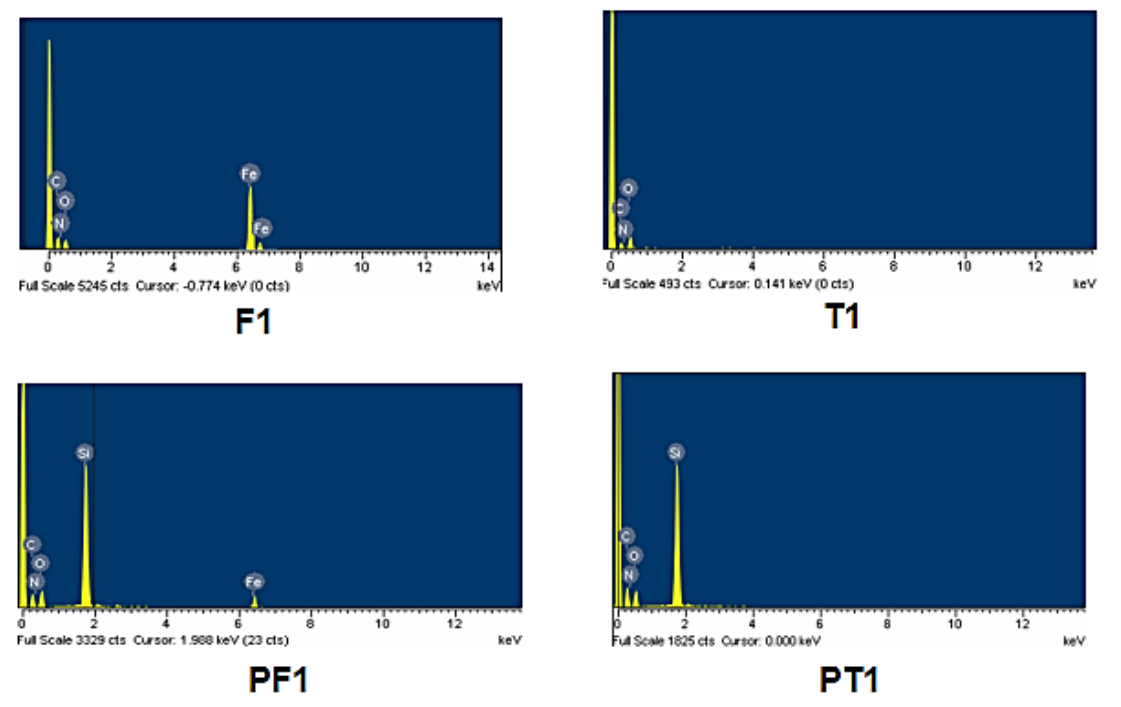
Figure 6. EDX spectra of representative terpolyamides and block copolymers.